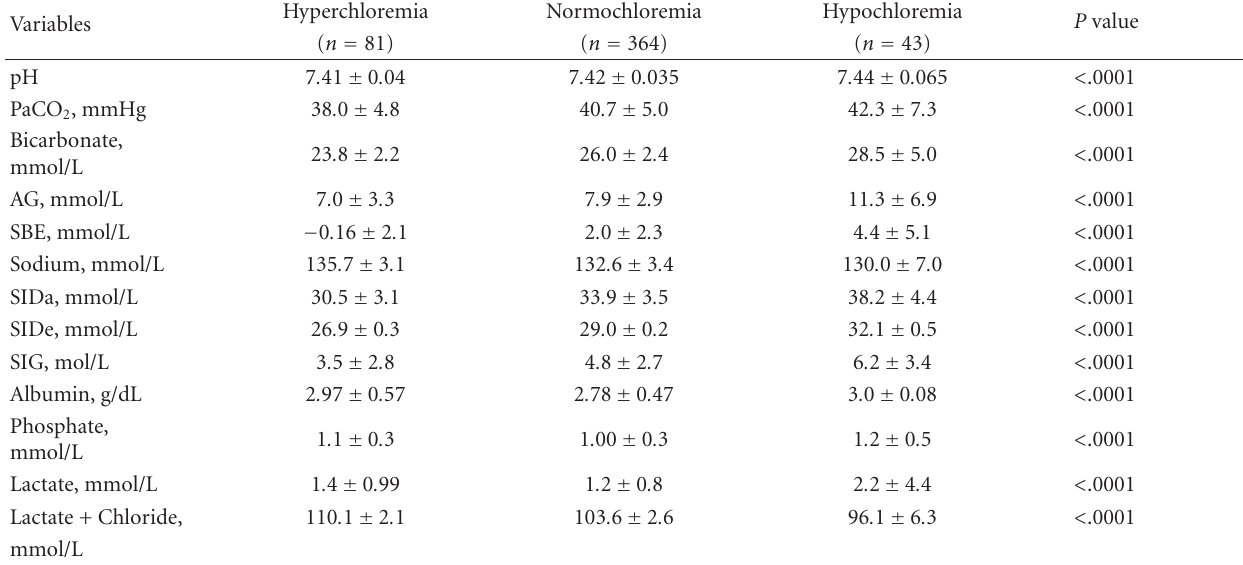
Table 2: Acid-base variables in hyperchloremic, normochloremic, and hypochloremic patients.